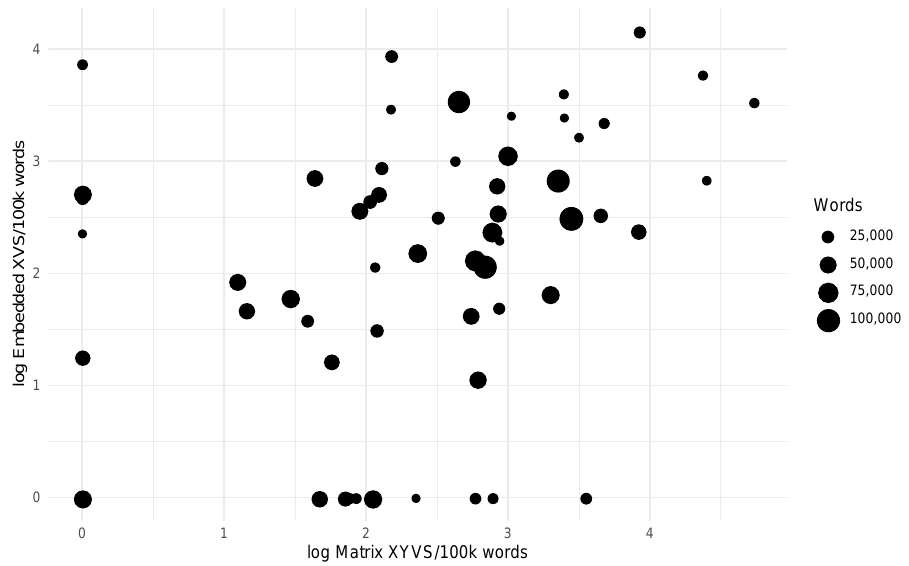
Figure 1. Frequency of matrix XYVS and embedded XVS orders in Old and Middle English texts of >10,000 words